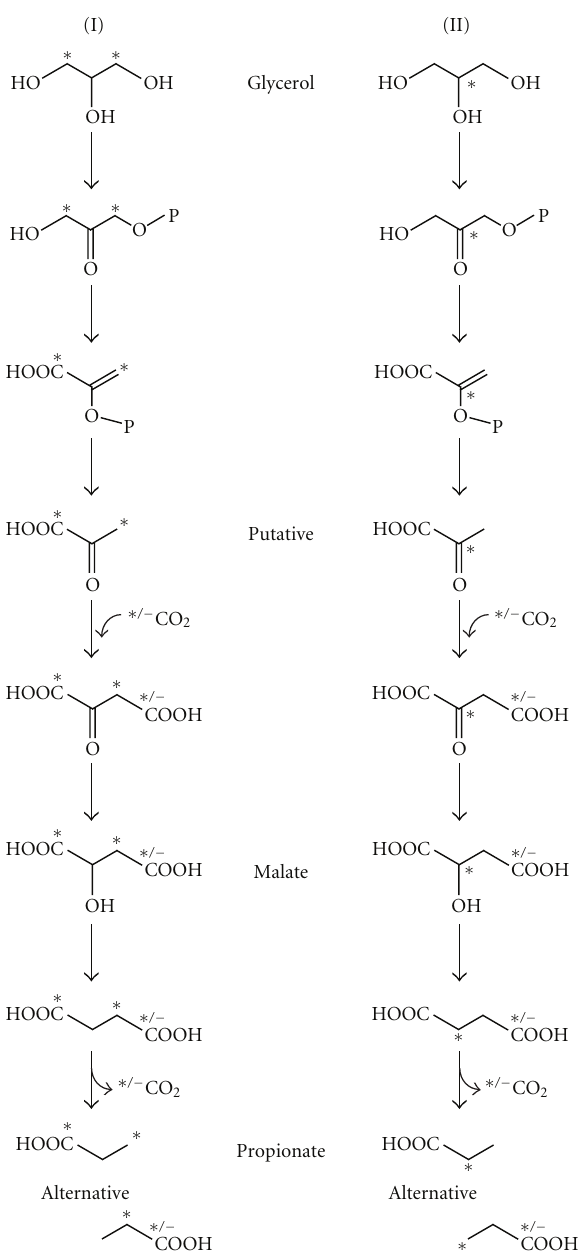
Figure 4: Schematic pathway for the formation of propionic acid from glycerol 13 C labeled at C 1 and C 3 (I) or C 2 (II) and 13 CO 2 (a by-product from 13 C-labeled glycerol breakdown, ∗ = 13